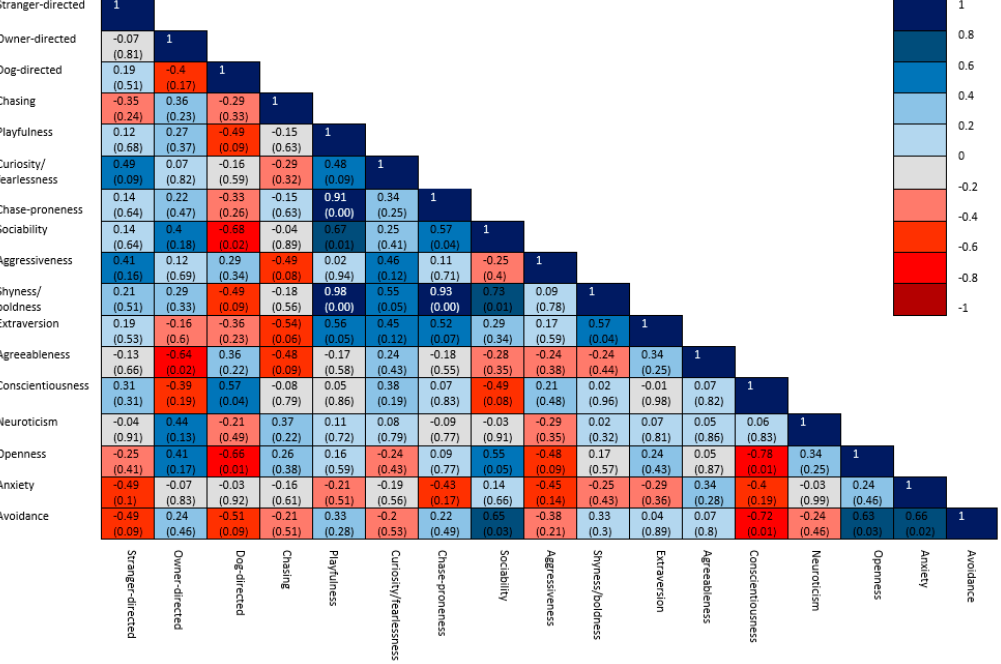
Figure 5. Correlation matrix of the coefficients of the variables in the group of dogs which were aggressive towards dogs and other animals, with significance levels in brackets.